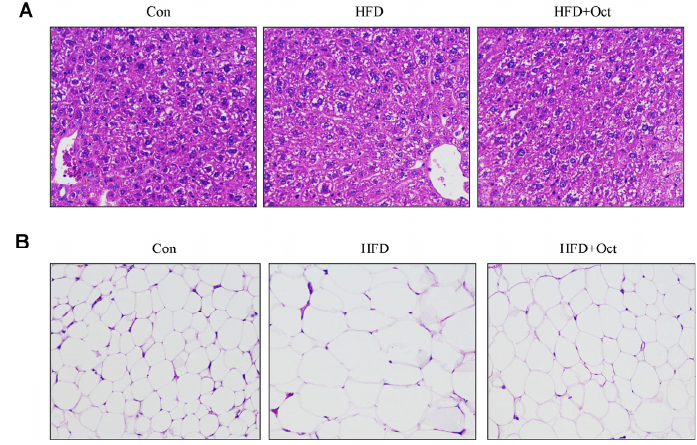
Figure 3. Octacosanol alleviates HFD-induced hepatic damage and decrease adipocytes size of retroperitoneal fat tissue. ( A ) H&E staining images of representative hepatic tissues of Con, HFD, and HFD+Oct groups; ( B ) H&E staining images of representative retroperitoneal fat tissue of Con, HFD, and HFD+Oct groups. Oct, octacosanol; HFD, high-fat diet. The blood samples of mice were collected to acquire the lipid profiles of plasma. Compared with Con group, TG level was obviously increased in the HFD group mice; the TG level in HFD+Oct group was 45.96% ( p < 0.05, Figure 4A) lower than that in HFD group. The results indicate that octacosanol could obviously reduce TG level of plasma in HFD mice. Likewise, compared with Con group, TC level was increased in the HFD group mice; TC level in HFD+Oct group was significantly reduced by 26.93% compared with HFD group ( p < 0.05, Figure 4B), indicating that intervention with octacosanol can signif- icantly inhibit the increase of TC level in HFD mice. Compared with HFD group, LDL-c level in HFD+Oct group was decreased by 47.93% ( p < 0.05, Figure 4C). Compared with HFD group, HDL-c level in HFD+Oct group decreased by 11.22% ( p = 0.06, Figure 4D), and the difference was not significant ( p ˃ 0.05, Figure 4D).